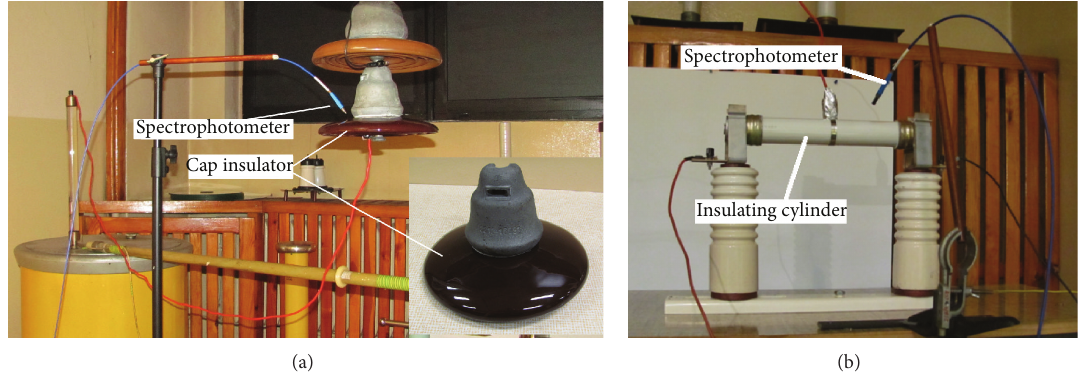
Figure 2: (a) The cap insulator, type LK, and (b) the cylindrical insulator, type